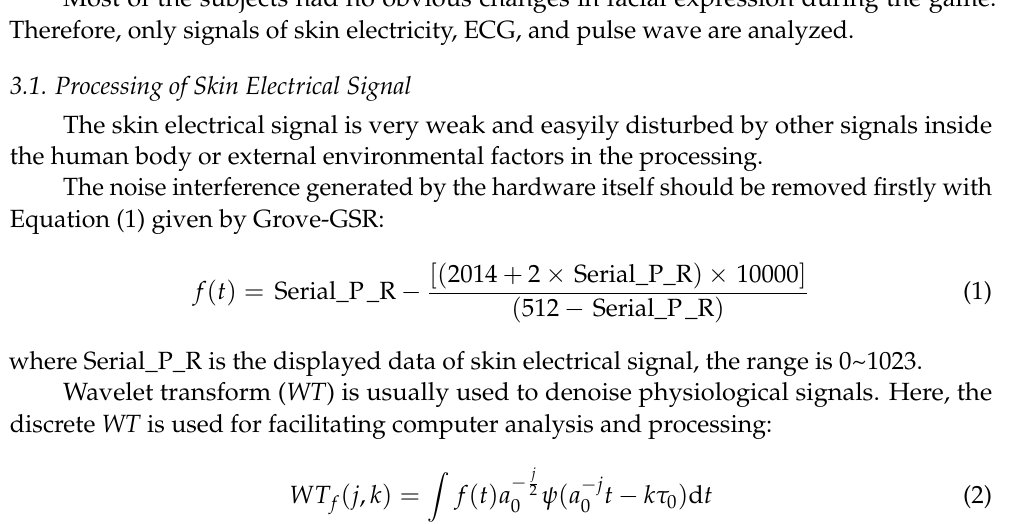
Figure 8. Segment cutting of skin electrical signal according to game events. 3.2. Processing of ECG Data Typical ECG waveform is shown in Figure 9,where the ECG shape is divided into single wave (P, T, U wave), QRS composite wave, P-R and Q-T interval, and ST segment; these four parts are combined to form a set of completed P-QRS-T-U waveform. The frequency band of ECG, QRScomposite wave, and P, T wave are generally 0.05~100, 3~40, and 0.5~10 Hz, respectively. The detection of ECG waveform is mainly aimed at QRS wave. Compared with other single waves, the frequency band of QRS wave is more centered, and R wave has high amplitude. Firstly, the repeated signal in the heartbeat interval is eliminated to recover the missed detection signal, and then the WT is used to remove the noise. The heartbeat interval refers to the time interval be- tween two heart beats, and it can be obtained by the RR interval of ECG signal. The RR interval is the time interval between the peaks of two adjacent R waves in the time do- main as shown in Figure 10.